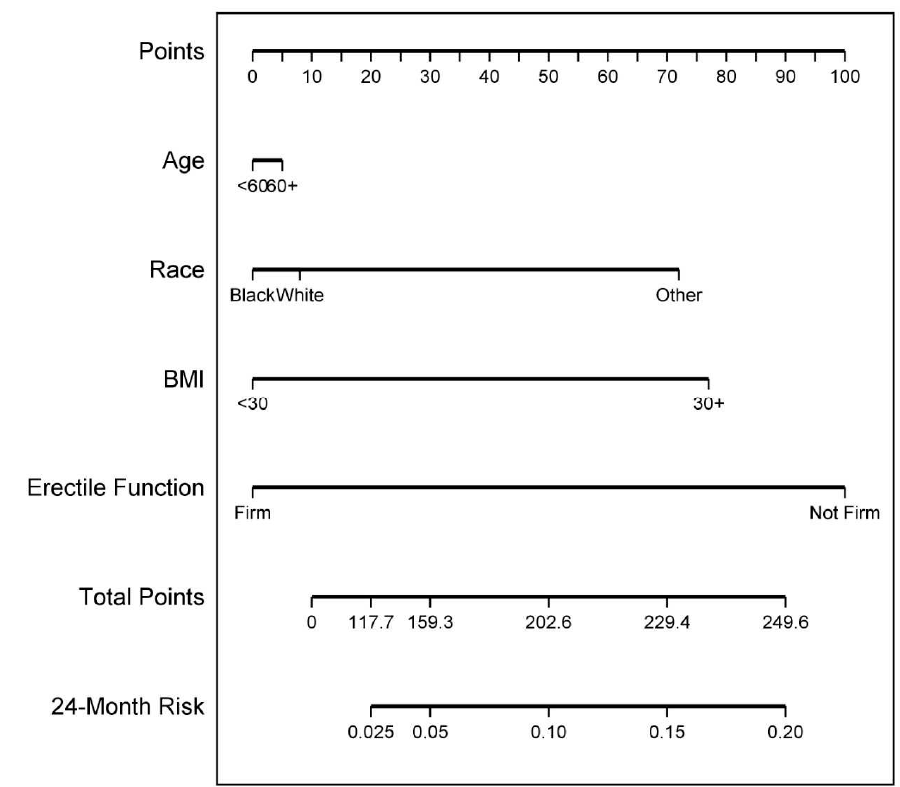
Figure 4. Twenty-four-month incontinence nomogram.